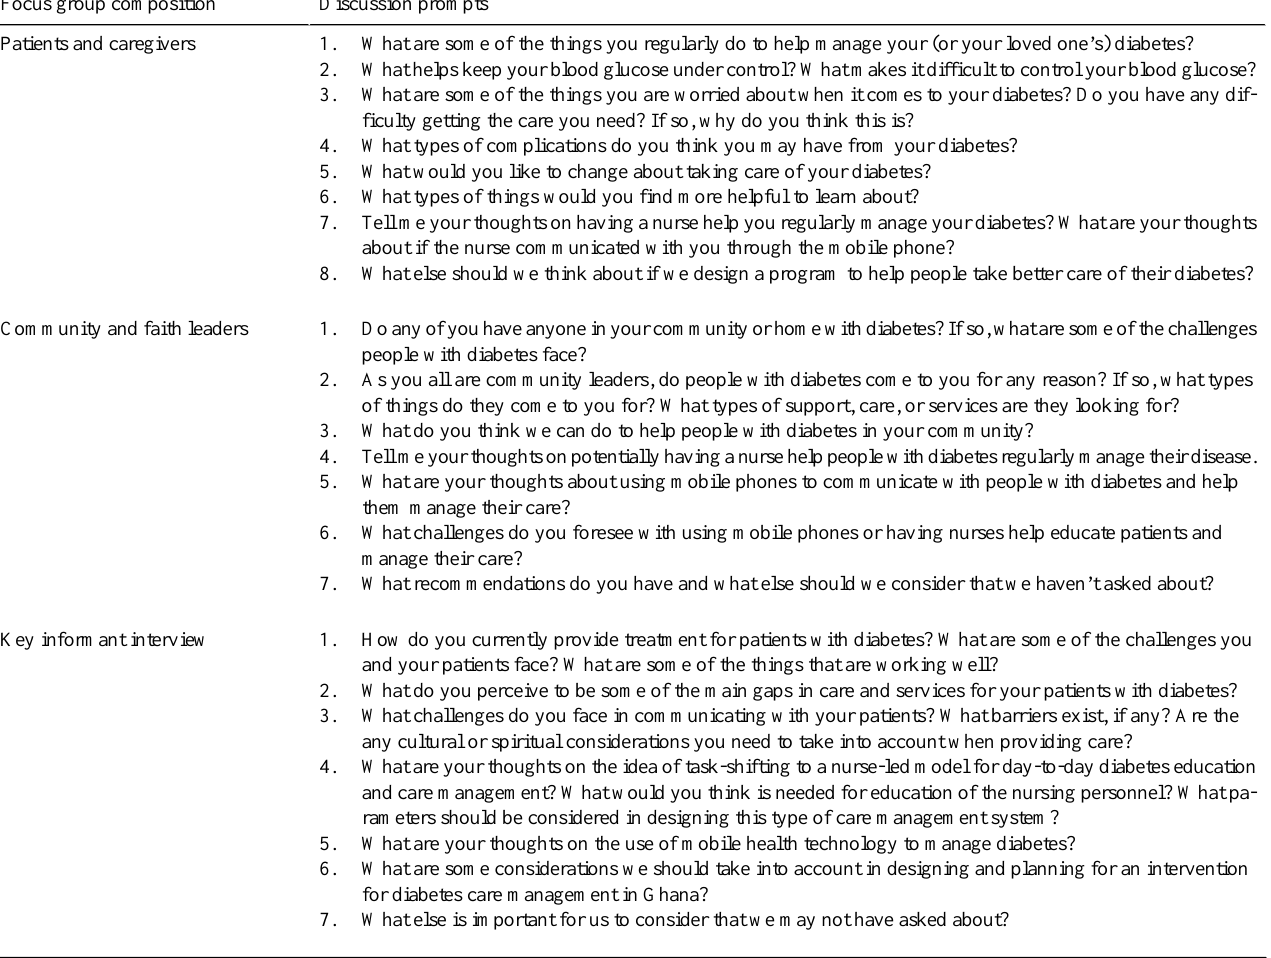
Discussion promptsFocus group